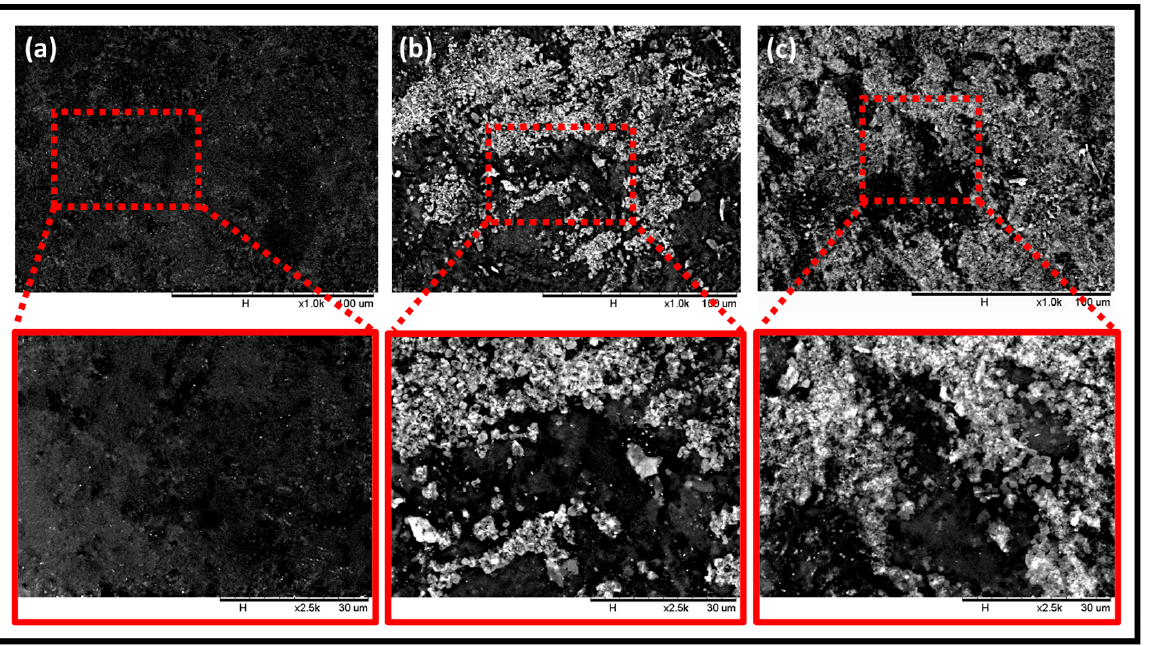
Figure 3. SEM images of seaweed/coffee biopolymer film at various filler loadings ( a ) control, ( b ) 1 wt% coffee and ( c ) 5 wt% coffee at 1000× and 2500× magnifications. wt% coffee and ( c ) 5 wt% coffee at 1000 × and 2500 ×